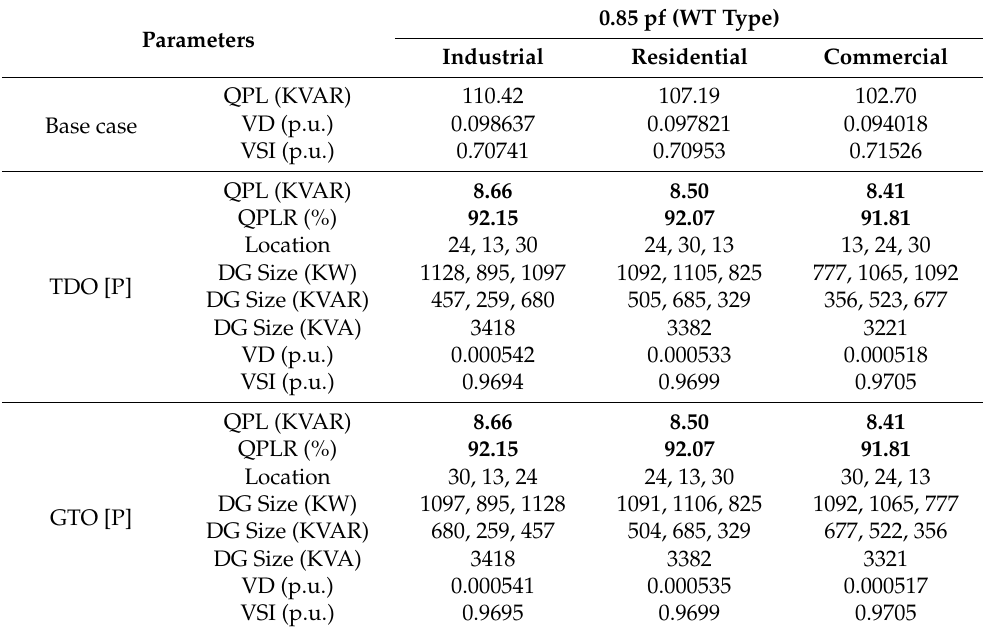
Table A4. Results of OADG for a 33-bus RDN for SOF (QPL minimization) at 0.85 pf (WT type) in a VP load model.